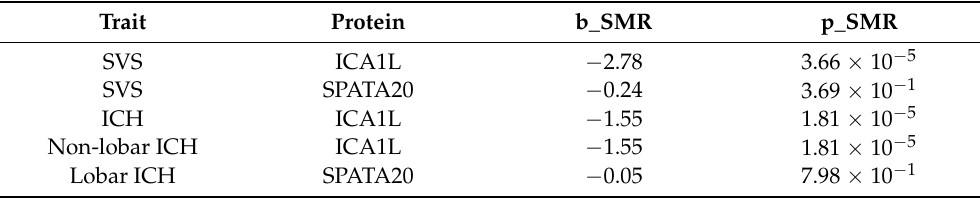
Table 2. SMR results.